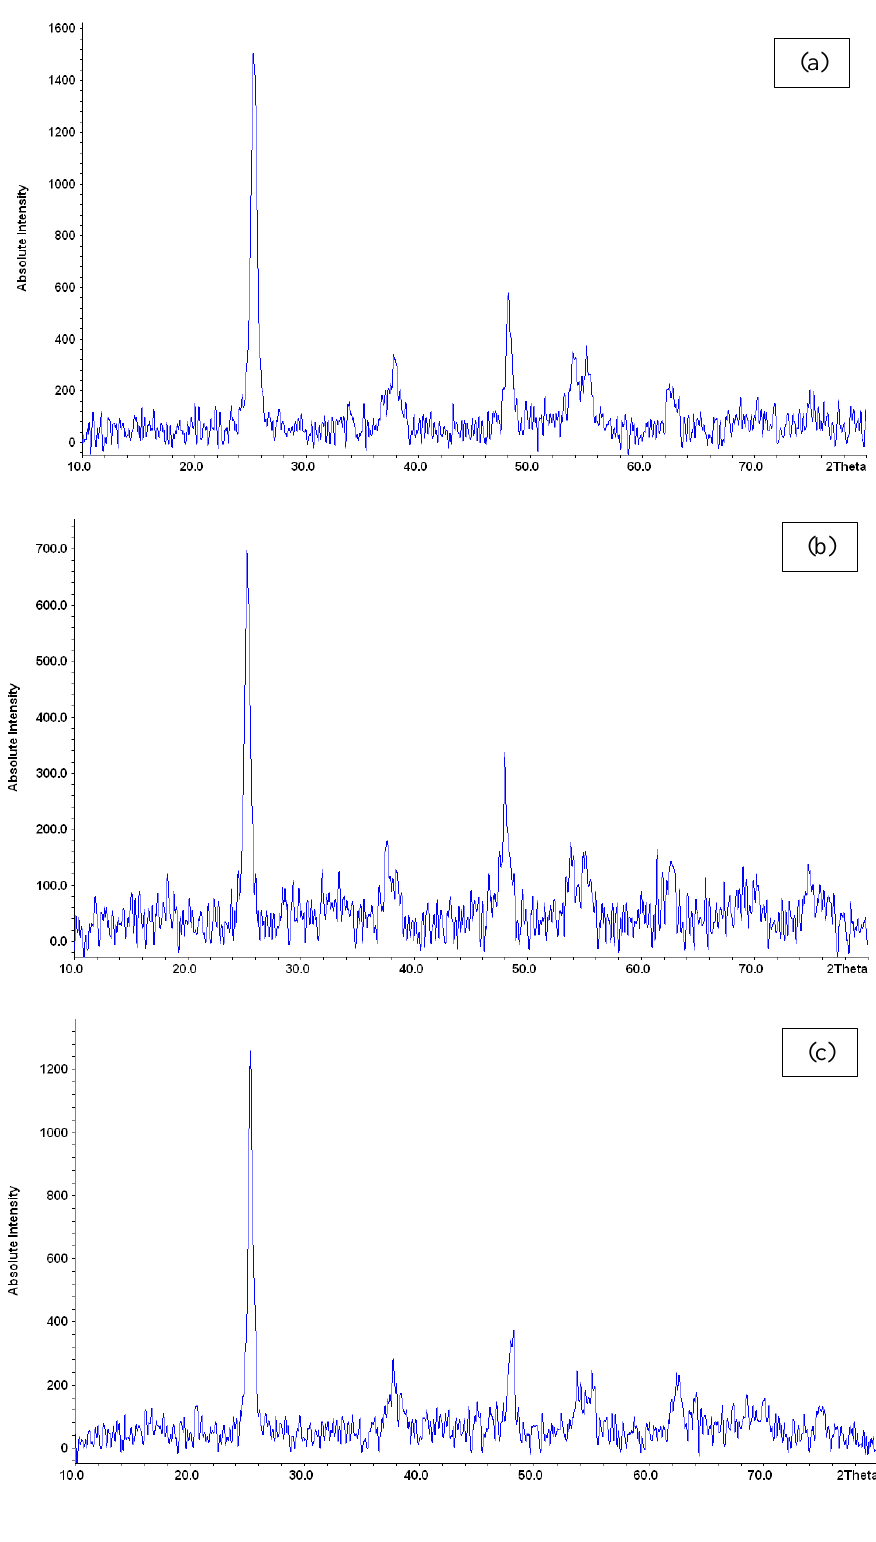
Figure 4. XRD patterns of powder samples (a) T, (b) TZ2, (c)